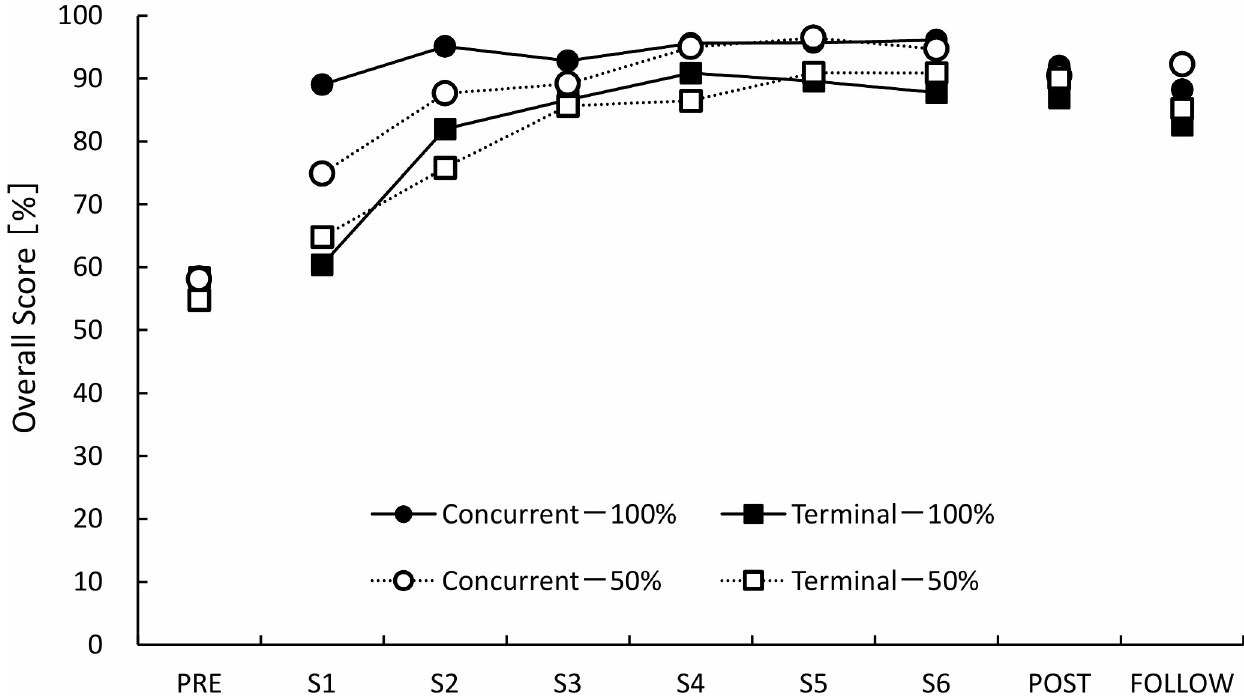
Fig 3. The transition of the overall score for each group. The overall score reflects the comprehensive performance on CPR including chest compression and ventilation. PRE: pre-test, S1: session 1, S2: session 2, S3: session 3, S4: session 4, S5: session 5, S6: session 6, POST: post-test, FOLLOW: follow-up test.